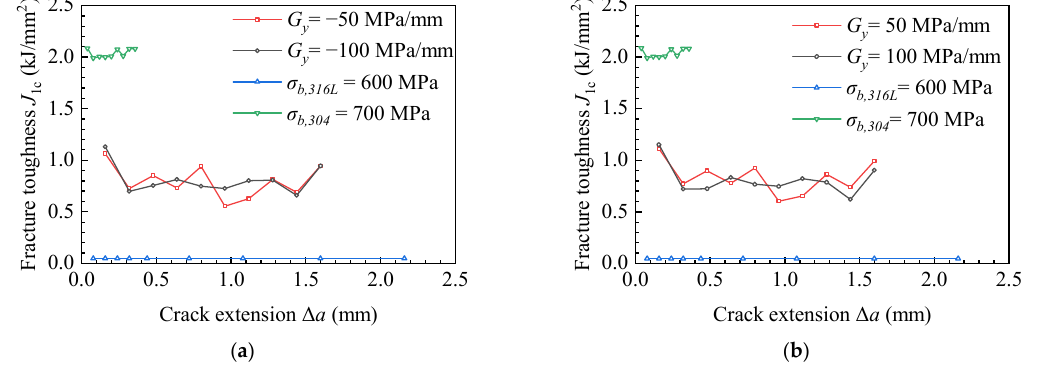
Figure 7. Fracture toughness during crack propagation with different ultimate strength mismatch coefficients in the y ‐ direction. ( a ) G y < 0 and ( b ) G y > 0. Figure 8 shows the contour of the maximum principal stress at the crack tip with the 0.6 mm a under the same geometric constraints. It is